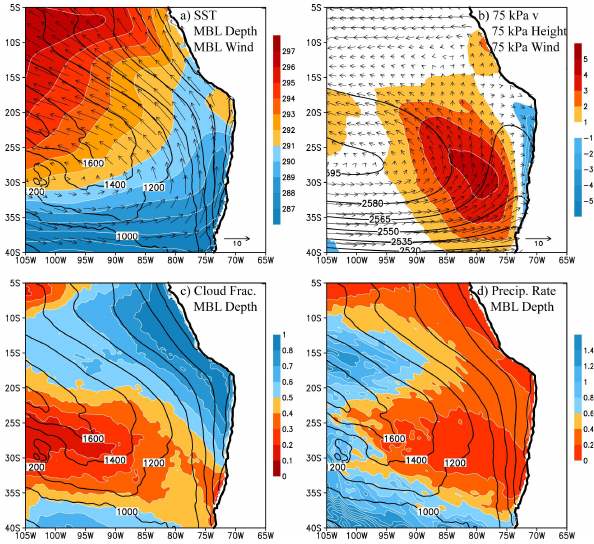
Fig. 3. October and November 2008 average of selected variables using the WRF simulation. (a) SST (K, color), MBL depth (m, con- tour), and wind at the top of the MBL (arrows,m s − 1 ), (b) 750hPa meridional wind component (ms − 1 , color), height (m, contour), and wind (arrows, ms − 1 ), (c) low ( < 3km) cloud fraction (color) and MBL depth (m, contour), and (d) average precipitation rate (color, mmd − 1 ) and MBL depth (m,